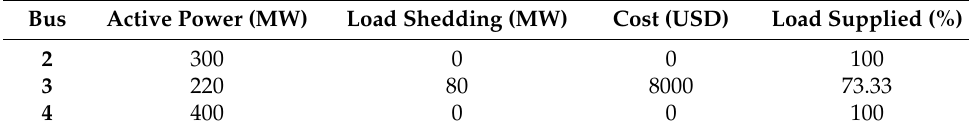
Table 11. Description of loads at buses 2, 3 and 4.